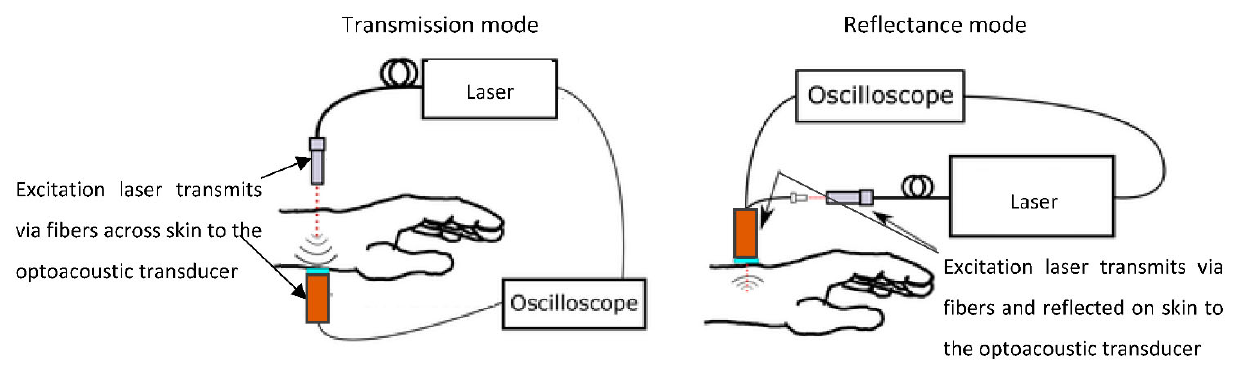
Figure 3. The experimental instrument for the optical setup, extracting the optical parameter to be compared to the Corneometer ® probe measuring capacitance. Modified from Kelman et al. [20].